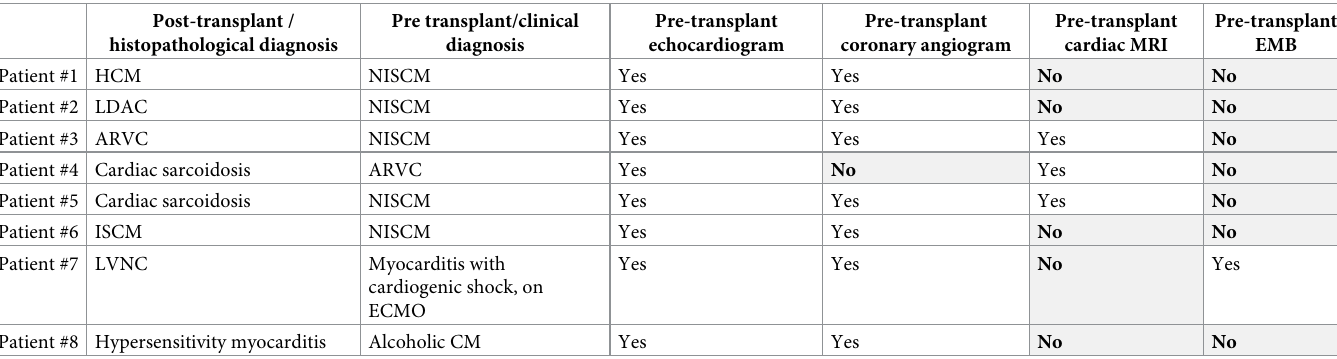
Table 3. Multimodality imaging in 8 patients with discordant